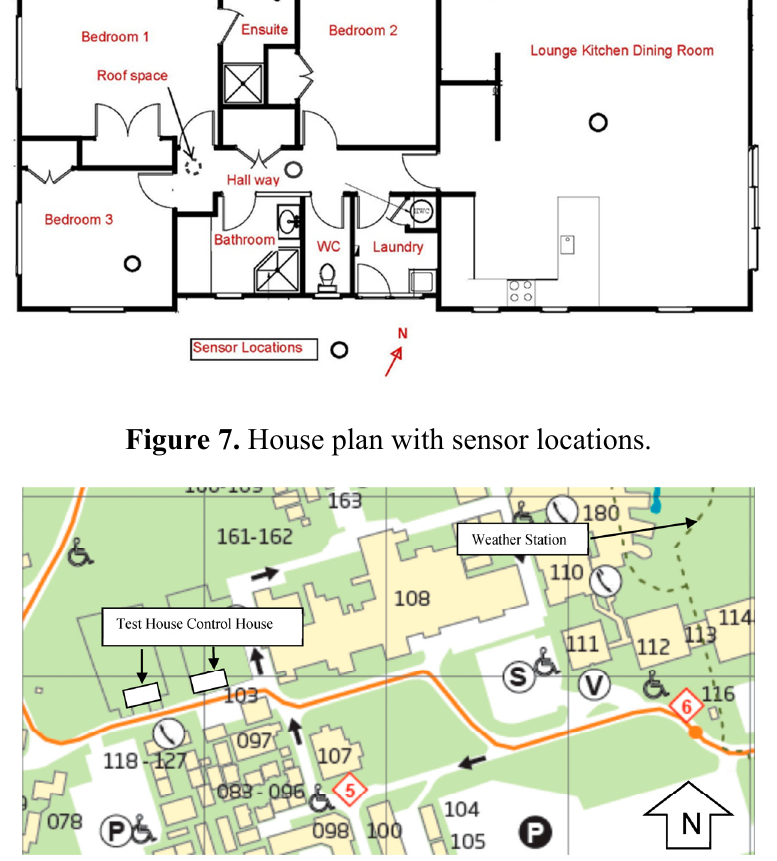
Figure 8. House and weather station location